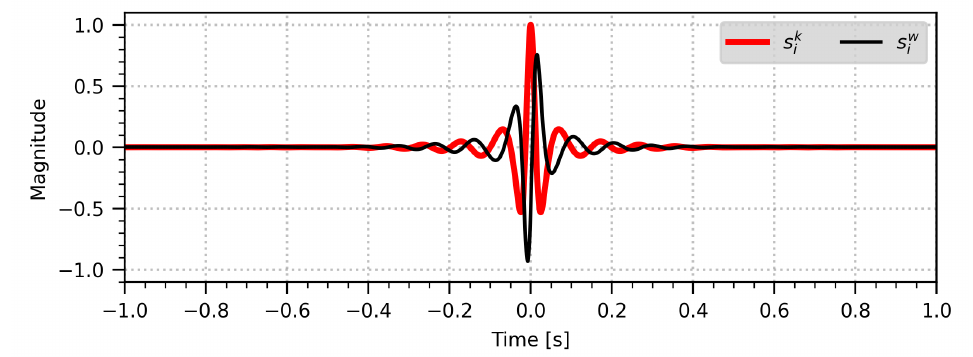
Figure 12. Comparison of the zero-phase Klauder source wavelet ( s k filtering of [10 Hz, 20 Hz] and wrong source wavelet ( s w